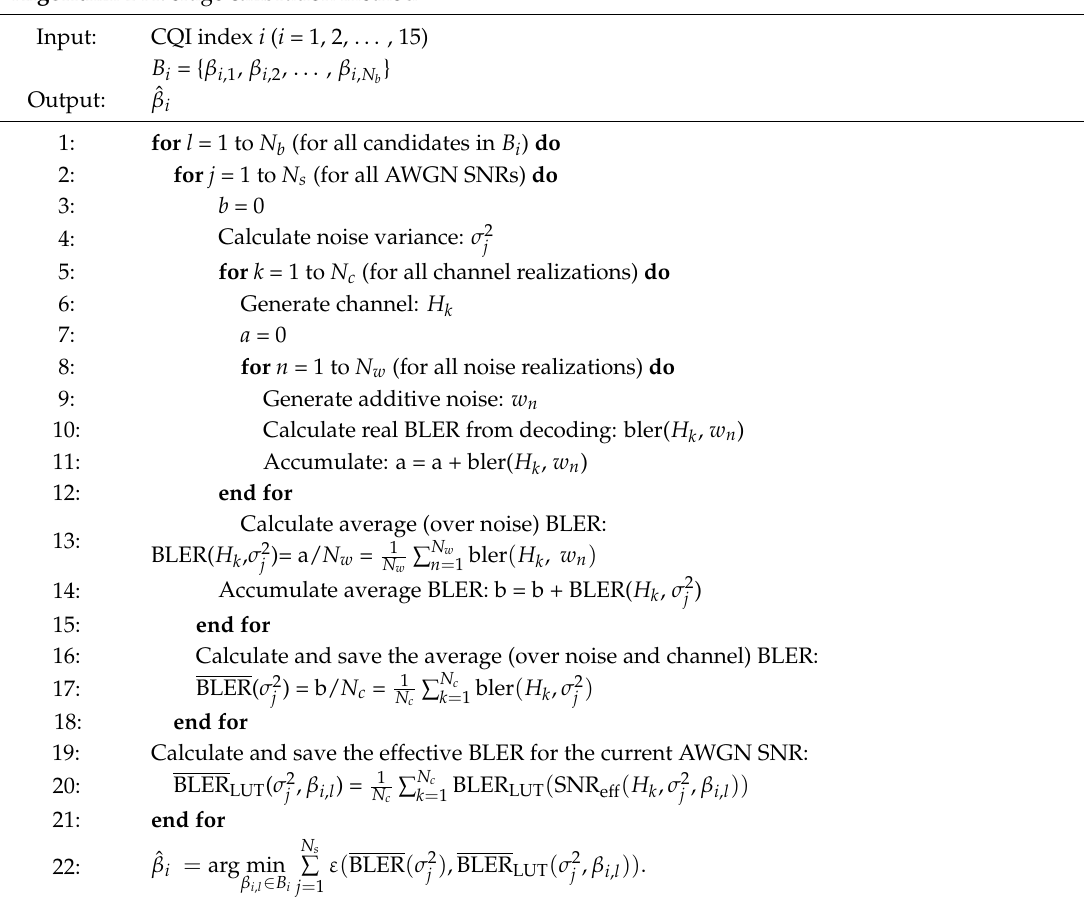
Algorithm 1 Average calibration